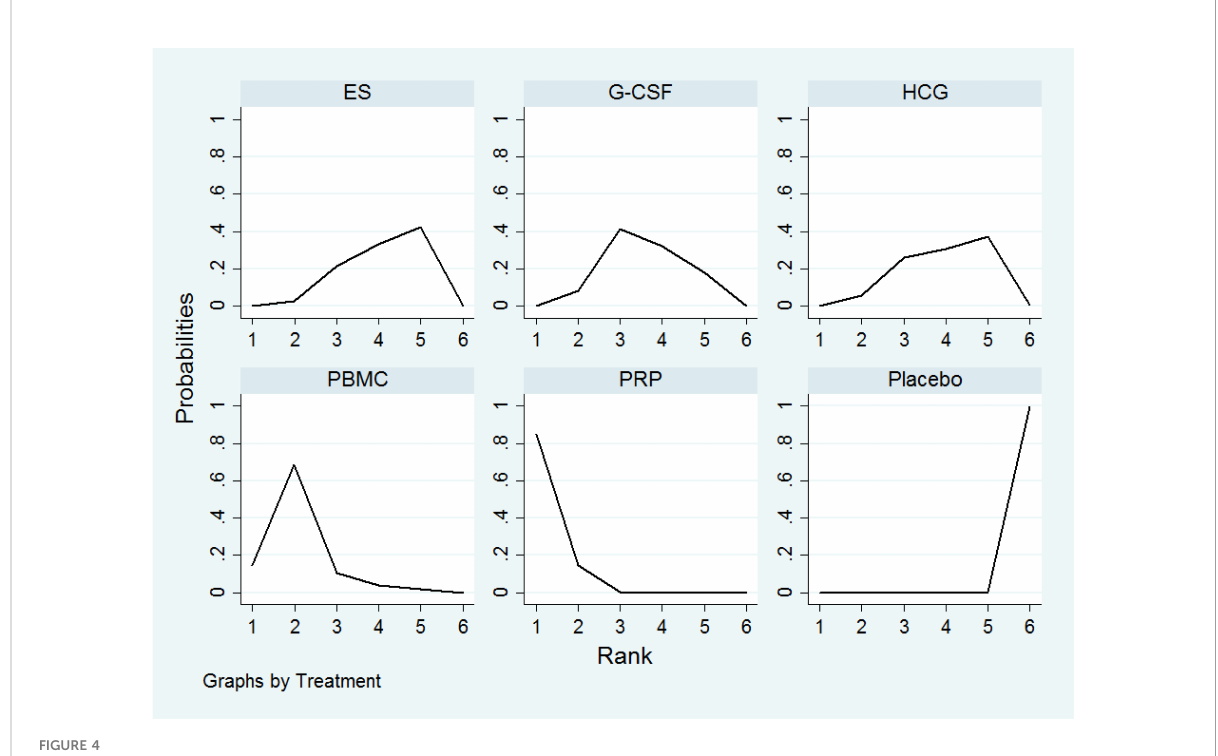
FIGURE 4 The ranking of intrauterine interventions for clinical